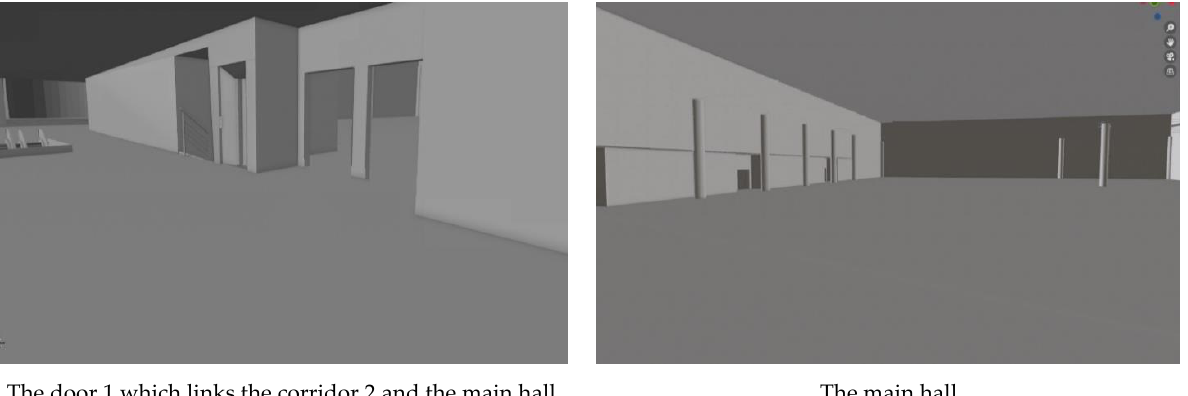
Figure 8. Indoor views of different spaces (corridors and the main hall) which show the complexity of surfaces in the Convention Center building.